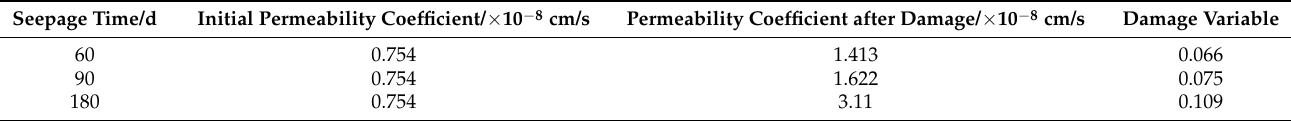
Table 2. The damage variables are calculated according to the permeability coefficient.